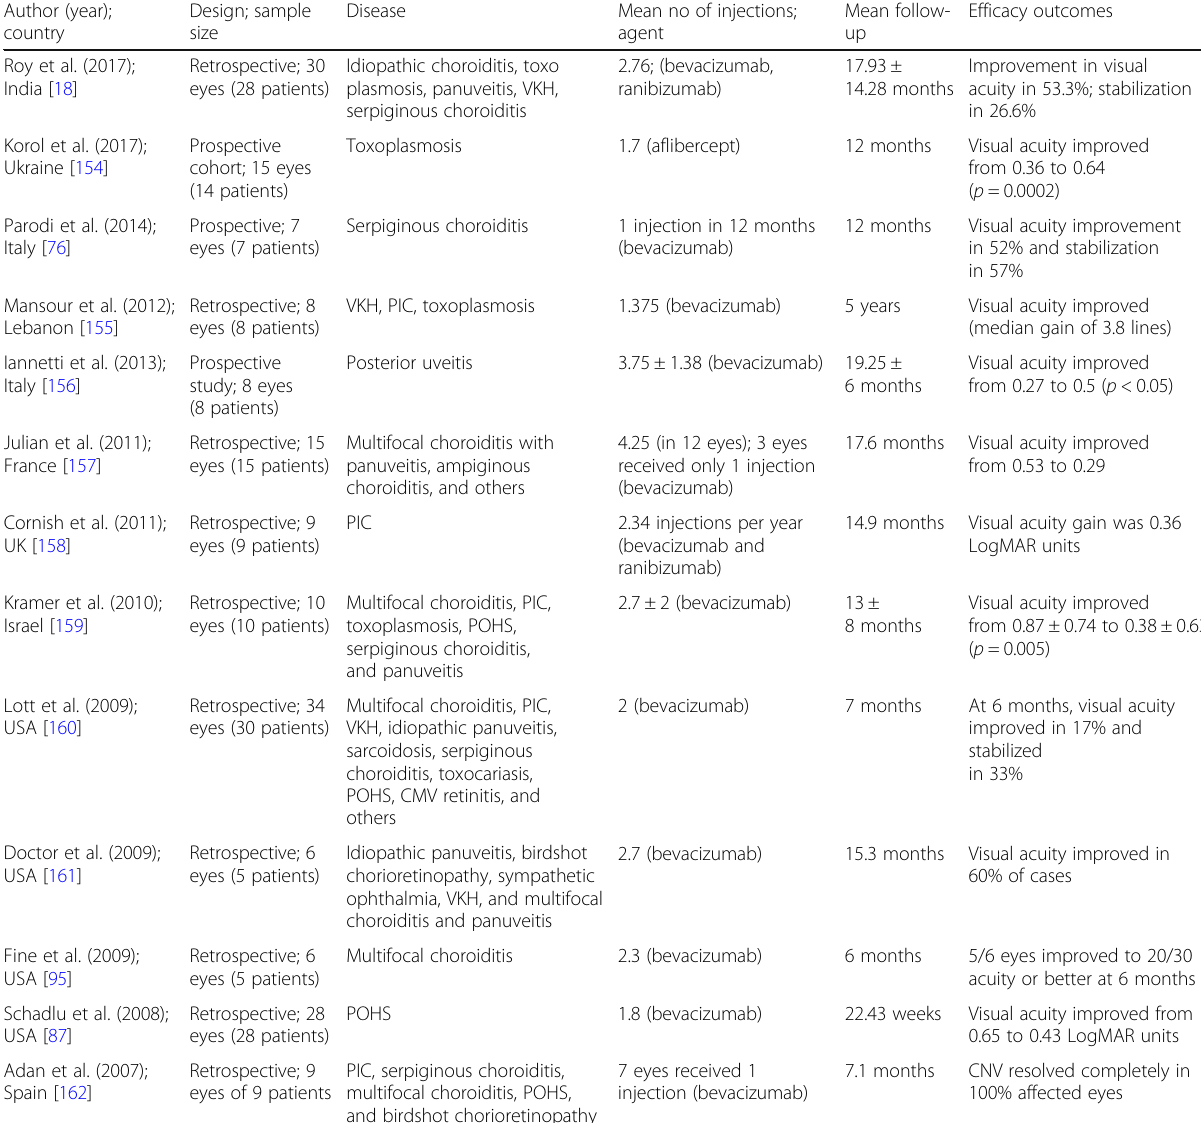
Table 4 Summary of studies showing the efficacy of anti-vascular endothelial growth factor therapy in inflammatory choroidal neovascularization (studies with sample size ≥ 5 eyes) Author (year);